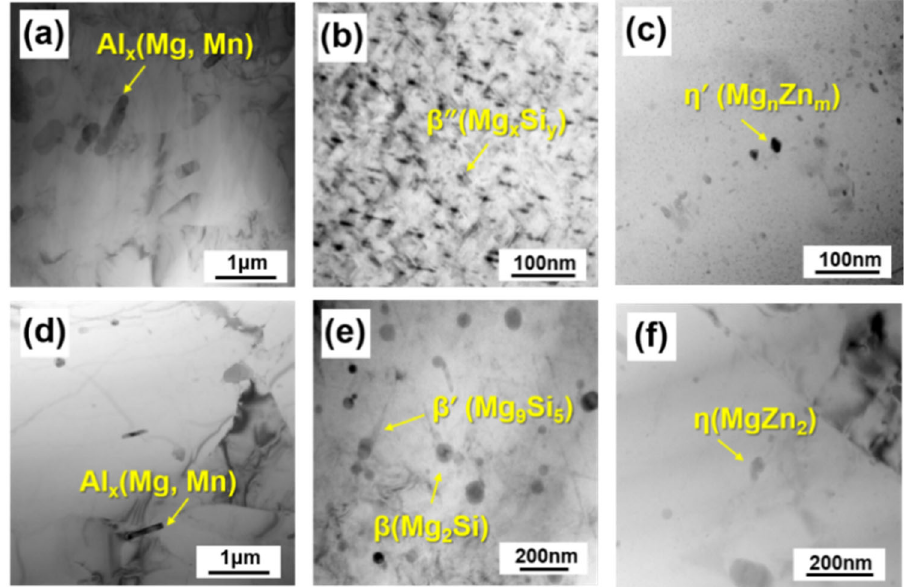
Figure 10. Bright-field transmission electron microscopy (TEM) micrograph of different aluminum alloy welded joints: 5083: ( a ) BM; ( d ) HAZ; 6005A: ( b ) BM; ( e ) HAZ; 7N01: ( c ) BM, ( f ) HAZ.